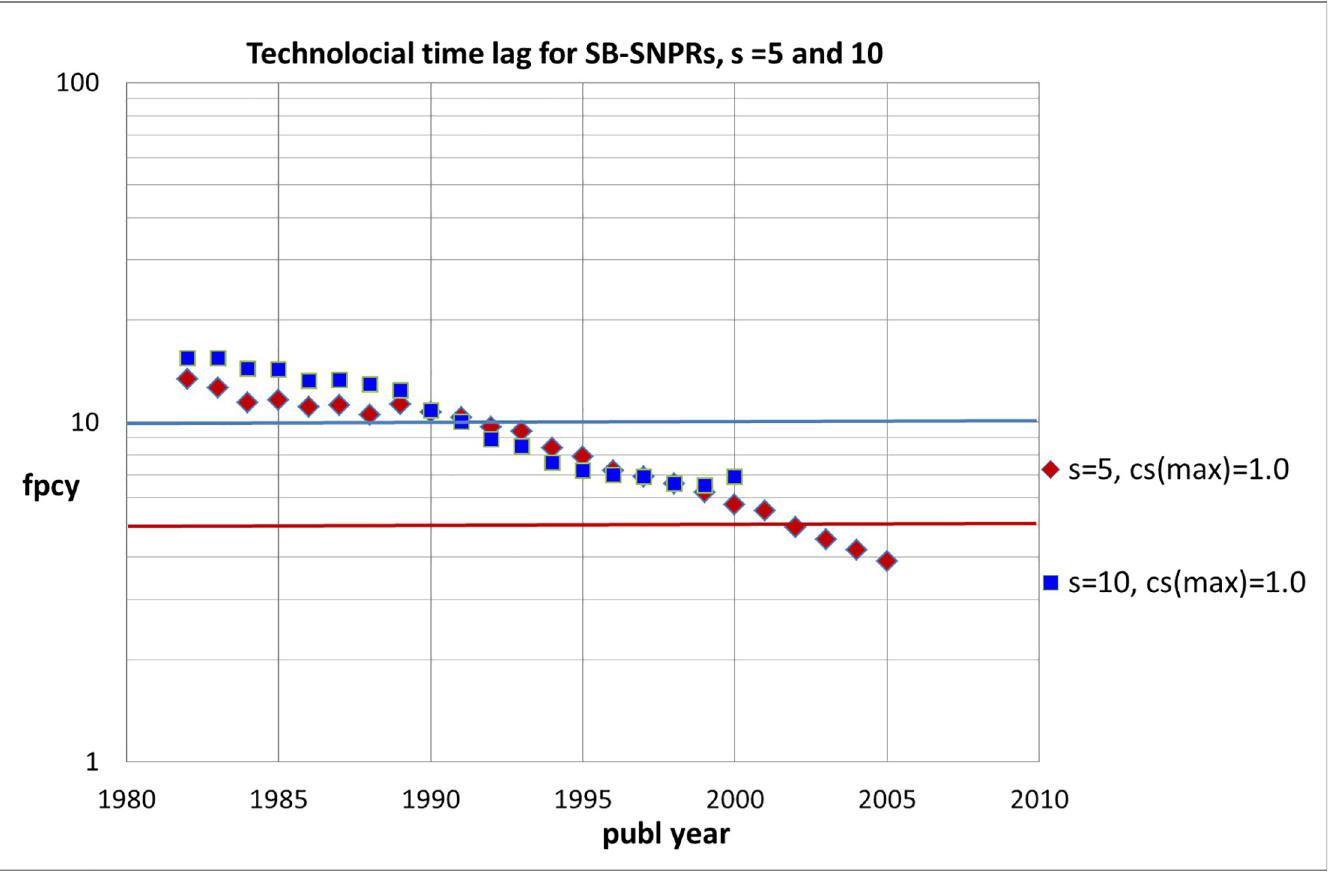
Fig 16. Technological time lag for SB-SNPRs with s = 5 (red diamonds) and s = 10 (blue squares). In both cases c abscissa are the middle years of the successive 5-years periods. The bold horizontal lines mark the lags ( fpcy ) of 5 (red line) and 10 years (blue line) which corresponds to the sleeping time for the SB-SNPRs with s = 5 and s = 10, respectively.